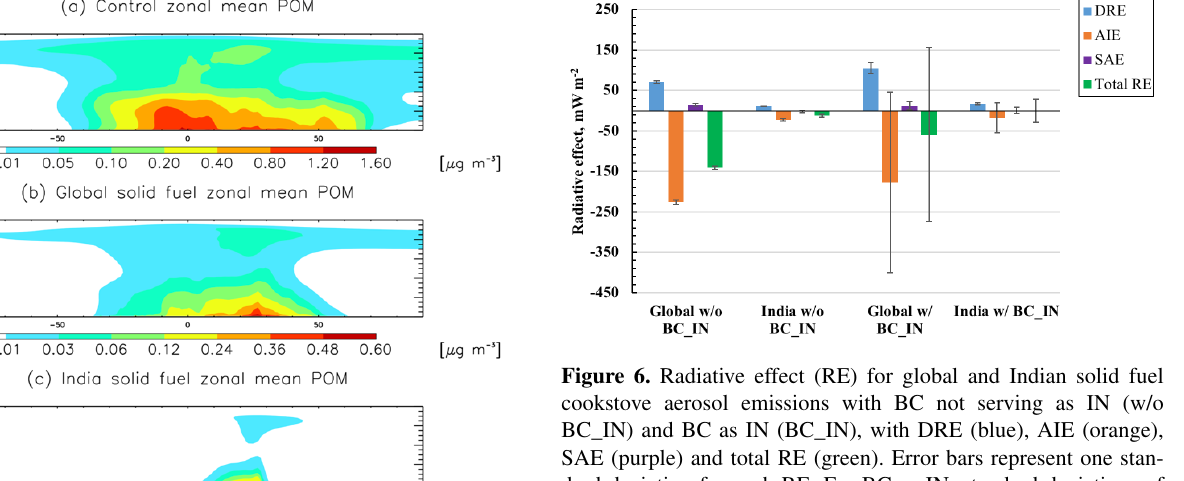
Indian solid fuel cookstove emissions are 0.13 ± 0.004 and 0.027 ± 0.002 Tg, respectively.